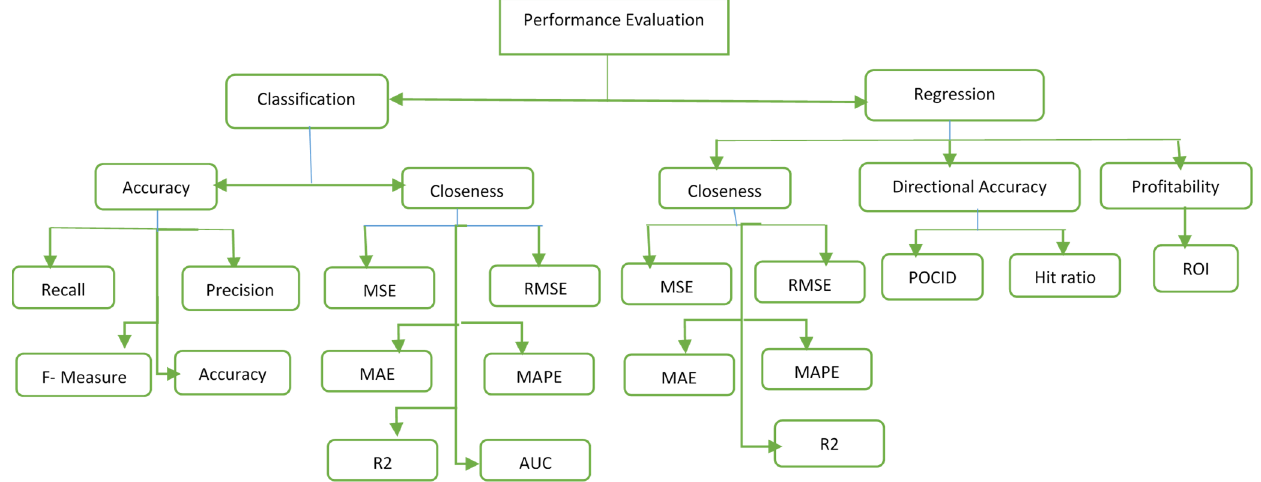
Figure 4. Taxonomy of the performance metrics.